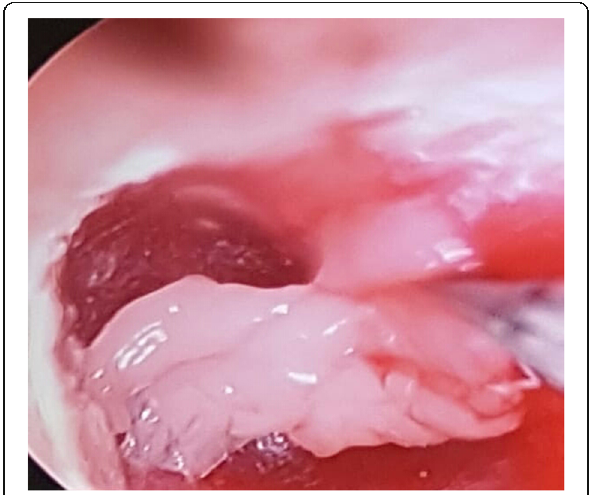
Fig. 4 Putting of PRF clot over the graft after adjustment of the graft in its place under the handle of